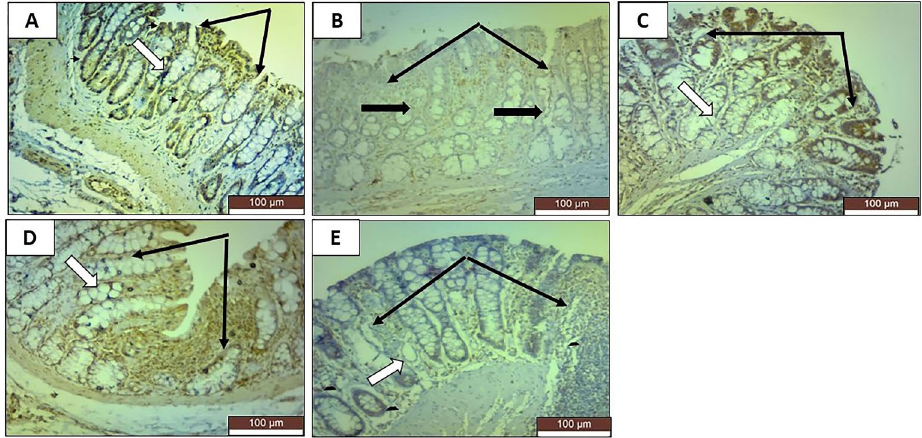
Figure 5. Photomicrographs of rat colonic sections stained for KI-67 immunoexpression in the mucosa ( (cid:4) 20, scale bar 100 m m). A , The normal control group shows strong positive reactions indicating extensive immunoexpression in crypt cells (white arrow) and surface cells (black arrows). B , The positive control group shows very faint positive reactions indicating very mild immunoexpression in crypt cells (thick black arrows) and surface cells (thin black arrows). C , The sulfasalazine group shows moderately positive reactions indicating moderate immunoexpression in crypt cells (white arrow) and surface cells (black arrows). D , The oral ro fl umilast group shows mildly positive reactions indicating weak immunoexpression in crypt cells (white arrow) and surface cells (black arrows). E , The rectal ro fl umilast group shows very mild positive reactions indicating very weak immunoexpression in crypt cells (white arrow) and surface cells (black arrows).